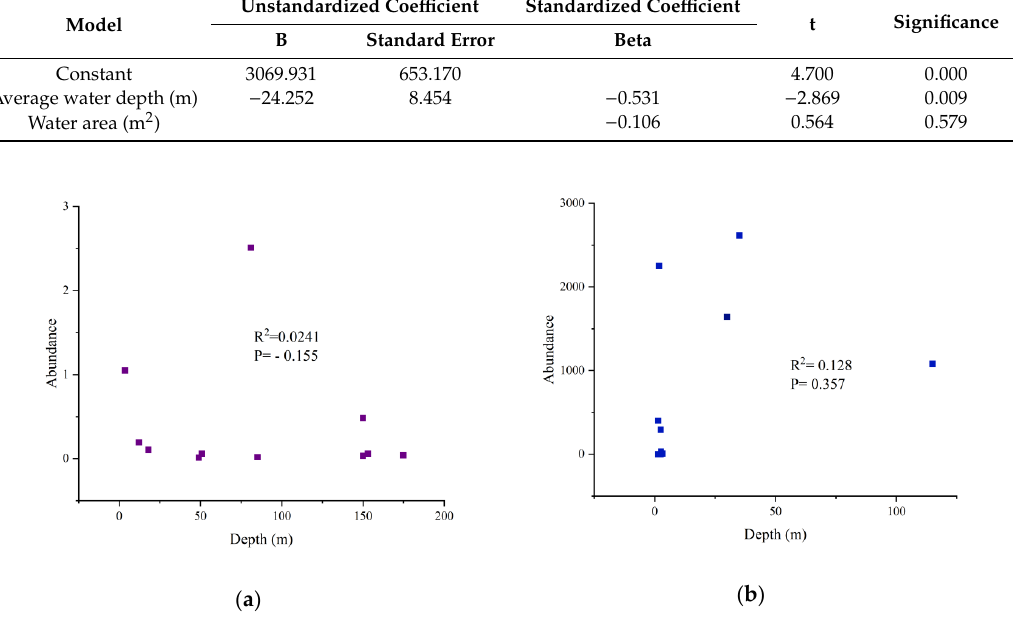
Figure 6. A scatter diagram of the correlation analysis between the microplastic concentration and average water depth in global freshwater bodies: ( a ) in developed countries; ( b ) in developing